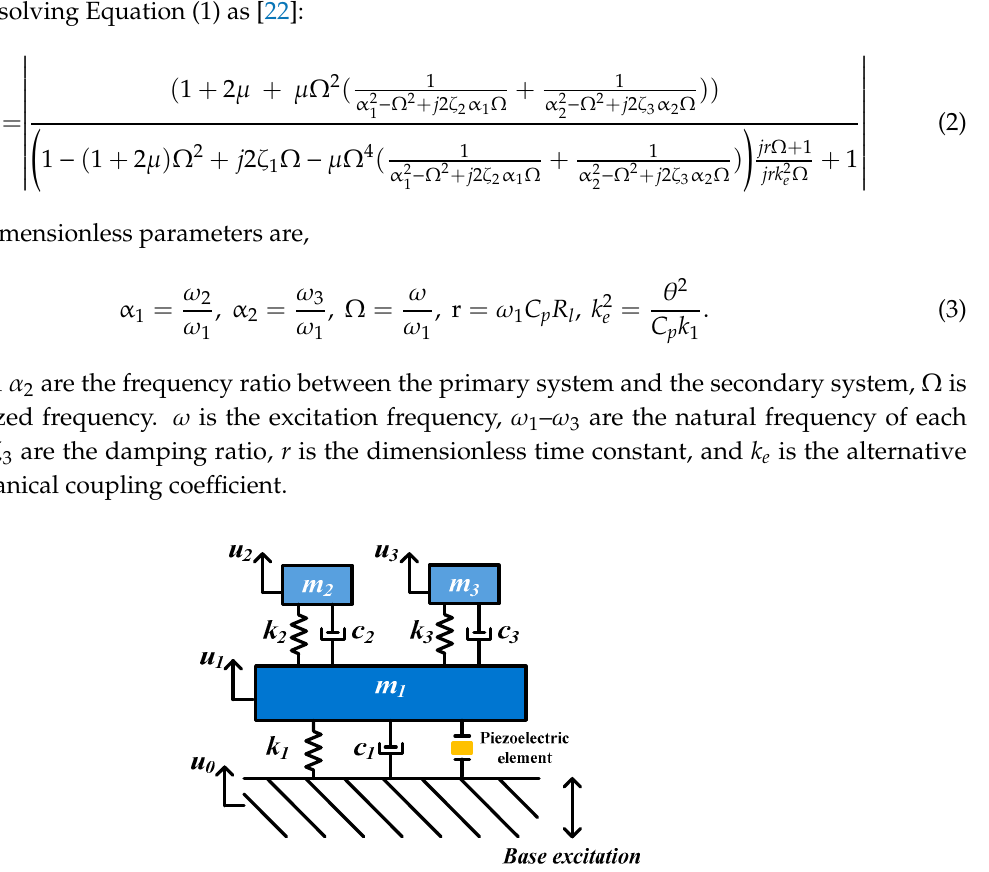
Figure 2. Equivalent mechanical model of the proposed PVEH.